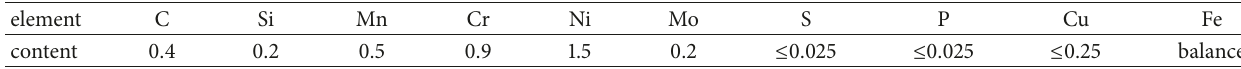
Table 1: Chemical composition of AISI4340 (Mass%).